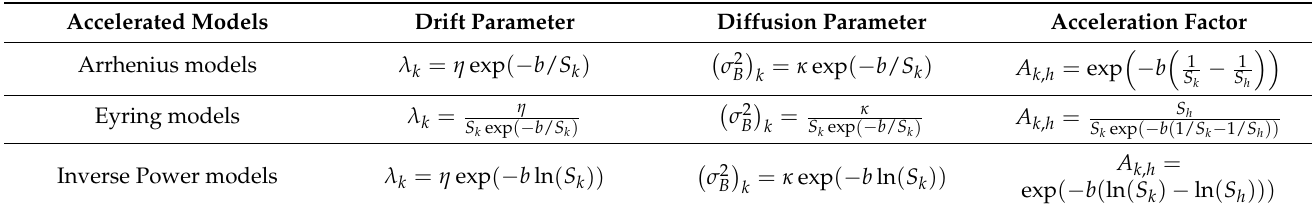
Table 1. Three different models and their acceleration